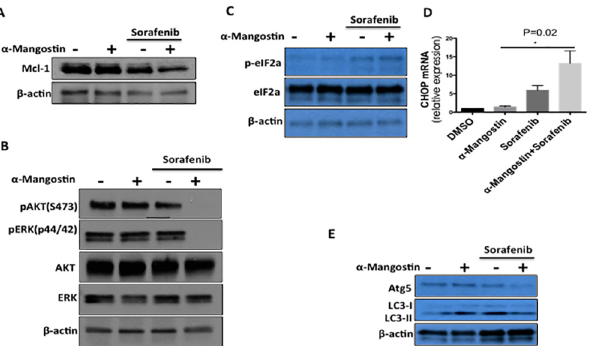
Fig 3. Impact of Sorafenib and α -Mangostin combination on AKT, ERK, and ER stress and autophagy markers. A, MCL-1 expression was suppressed by Sorafenib (5 μ M) and α -Mangostin (2 μ M) treatment for 8 hours in SK-MEL-2 cells. B, Down regulation of phosphorylation of AKT and ERK is much stronger at three hours treatment with the combination of Sorafenib (5 μ M) and α -Mangostin (2 μ M) as compared to single agent treatments. C, The increased expression of phosphorylation of eIF2 α were induced by the combination of Sorafenib and α -Mangostin for 8 hours, indicating ER stress. D, The relative mRNA expression level of CHOP. SK-MEL-2 cells were treated with Sorafenib (2 μ M), α -Mangostin (2 μ M) or their combination for 3 hours. The relative mRNA expression level of CHOP was detected by real-time polymerase chain reaction (PCR). Data shown are the means ( ± SEM) from at least three independent experiments. The statistical significance increase of CHOP expression was determined by Student ’ s T test (P = 0.02). E. Atg5 and LC3II levels were detected after the treatment of Sorefenib (5 μ M) or α -Mangostin (2 μ M).